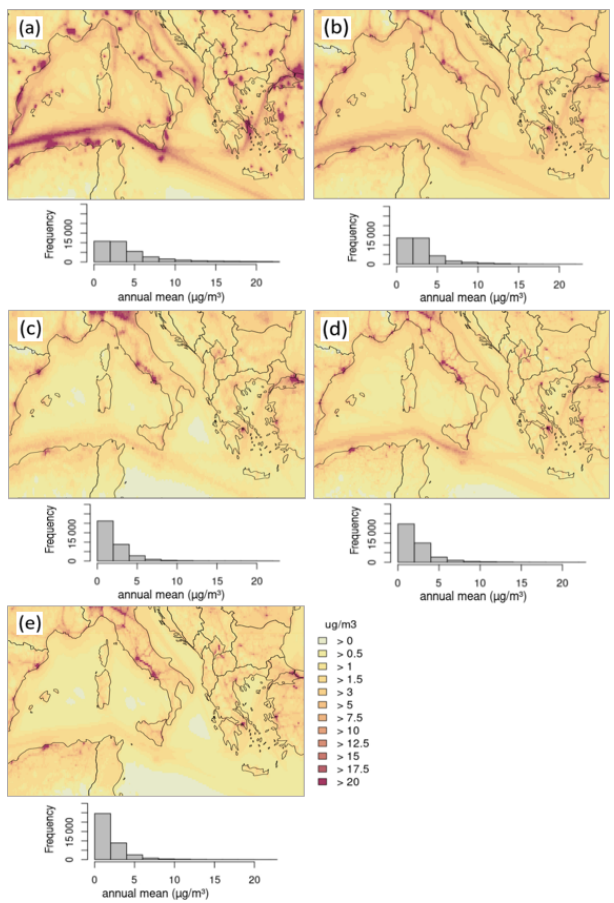
Figure E2. Annual mean relative potential ship impact of NO x . the domain figure the respective frequency distribution is displayed for the annual mean relative potential ship impact of NO x , referring to the whole model